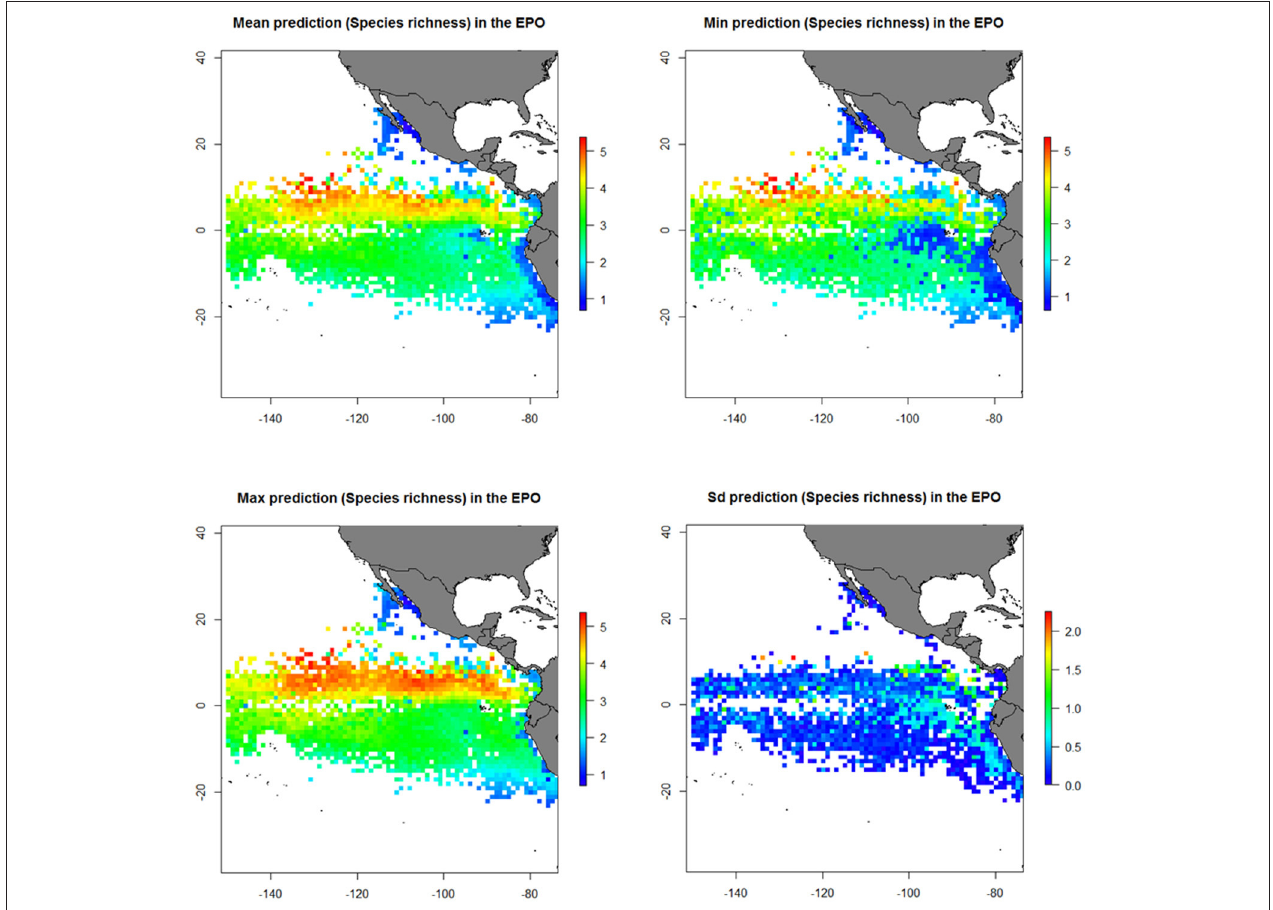
FIGURE 5 | Predicted diversity (Species richness index) of the bycatch assemblages in FAD and School sets in the eastern Pacific Ocean (EPO) from the generalized additive model (GAM). Mean diversity (upper-left) ; Maximum diversity (bottom-left) ; Minimum diversity (upper-right) ; Standard deviation of diversity (bottom-right)